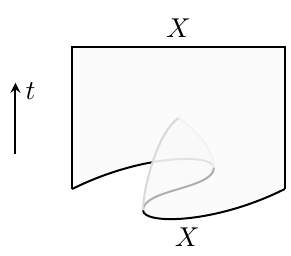
Figure 6. Straightening a string X is an instanton.